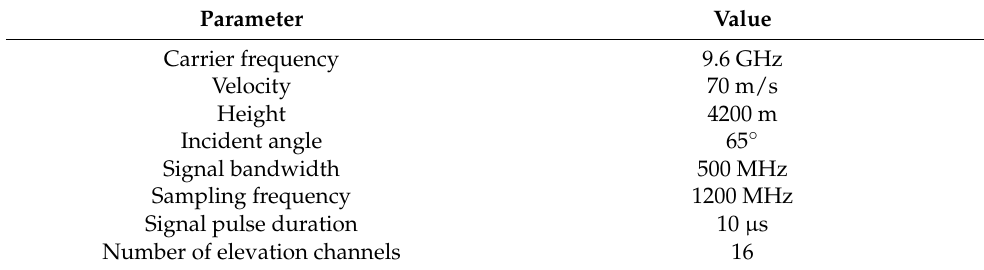
Table 4. Experimental System